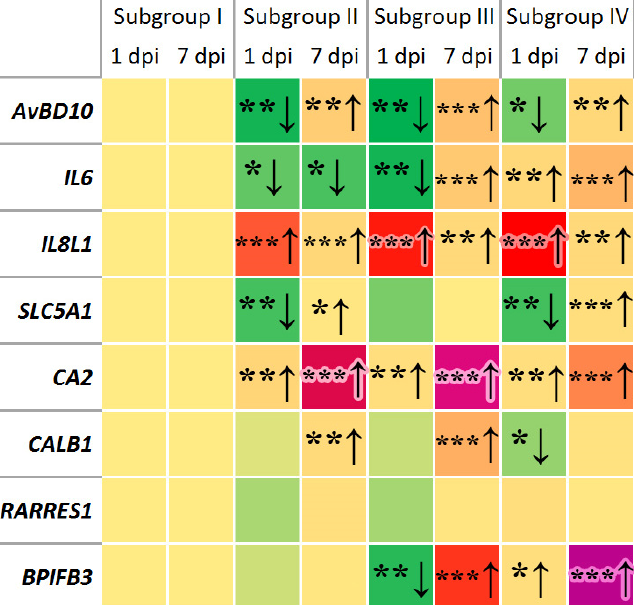
Figure 1. Heat map showing the expression of the chicken genes involved in response due to the Salmonella enterica serovar Enteritidis (SE) challenge and/or phytobiotic intake. Red and green squares correspond to significant gene up- ( ↑ ) or downregulations ( ↓ ) relative to the negative control (S-I) at p < 0.05 (*), p < 0.01 (**), and p < 0.001 (***). Yellow squares and other squares with no “*” mean, respectively, the basal expression level in S-I (negative control) or no significant changes in the experiment subgroups. dpi: days post-inoculation.